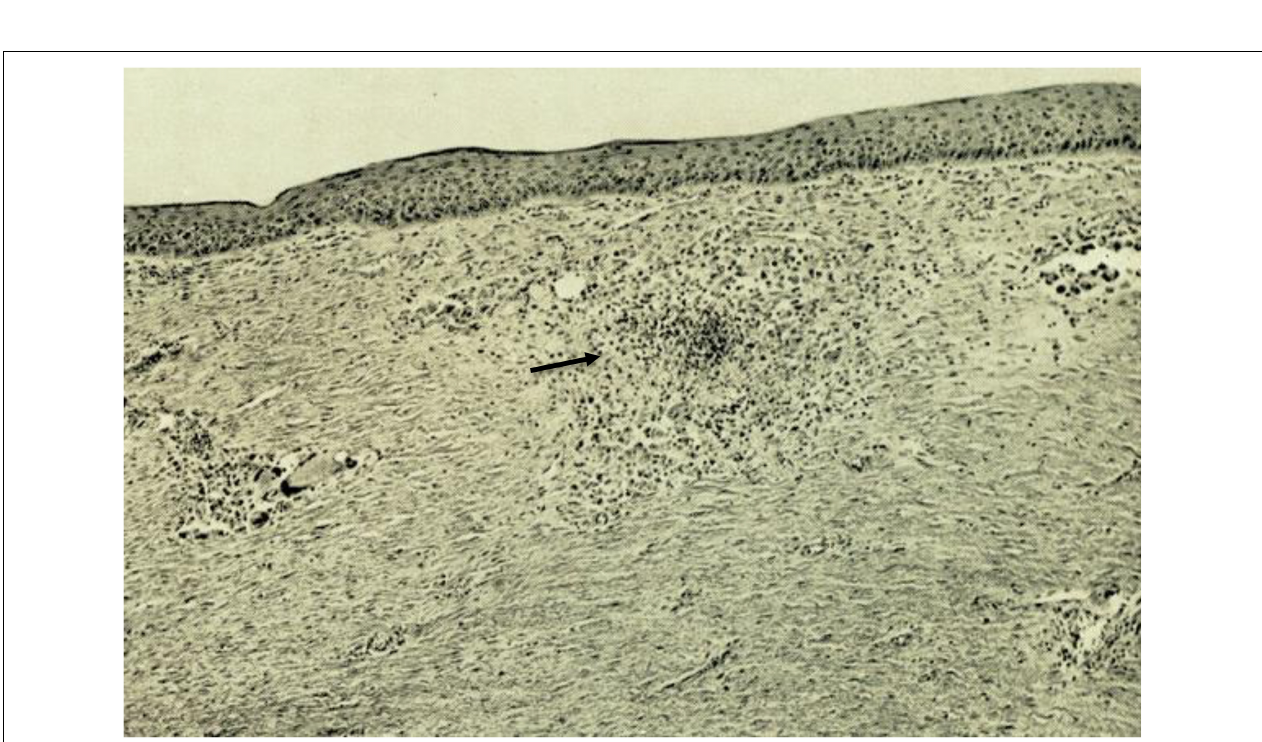
FIGURE 2 | Granulomatous reaction in the dermis; see